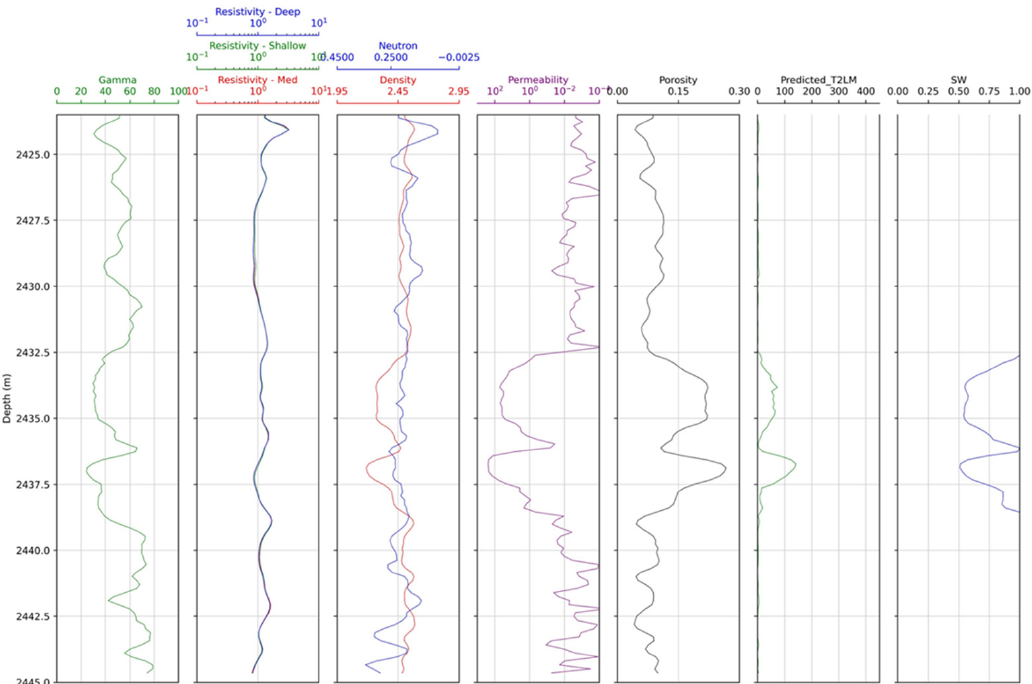
Figure 19. Predicted NMR T 2 LM for Reservoir B in new well.